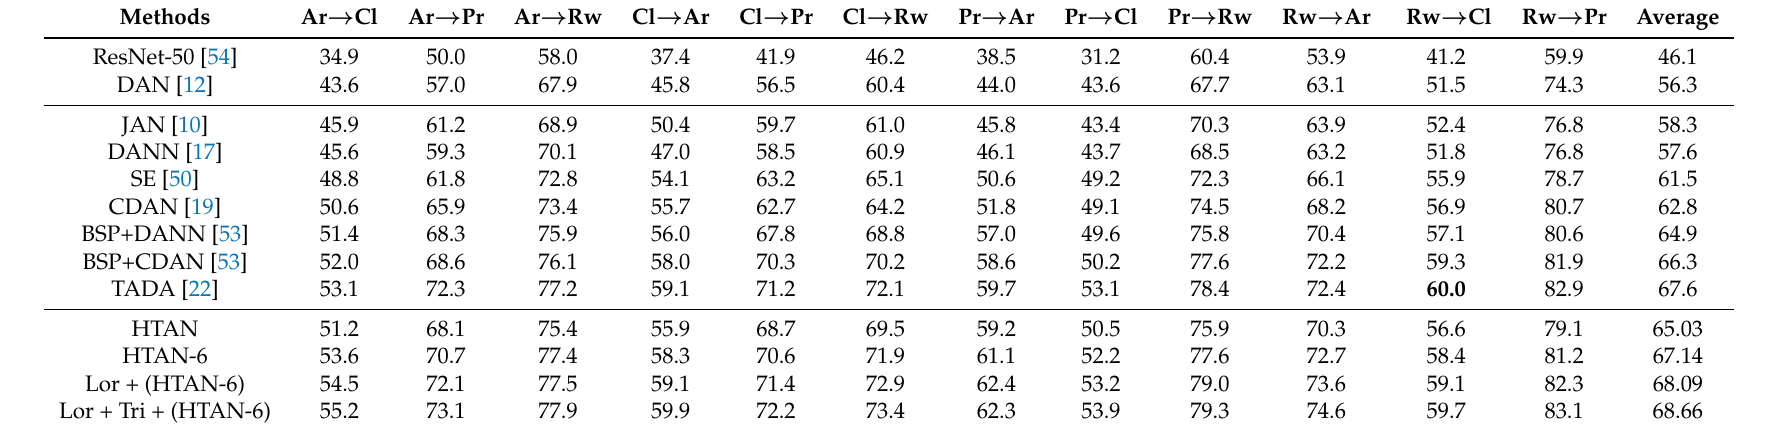
Table 3. Accuracy (%) on the Office-home dataset for unsupervised domain adaptation (ResNet-50 as base network).